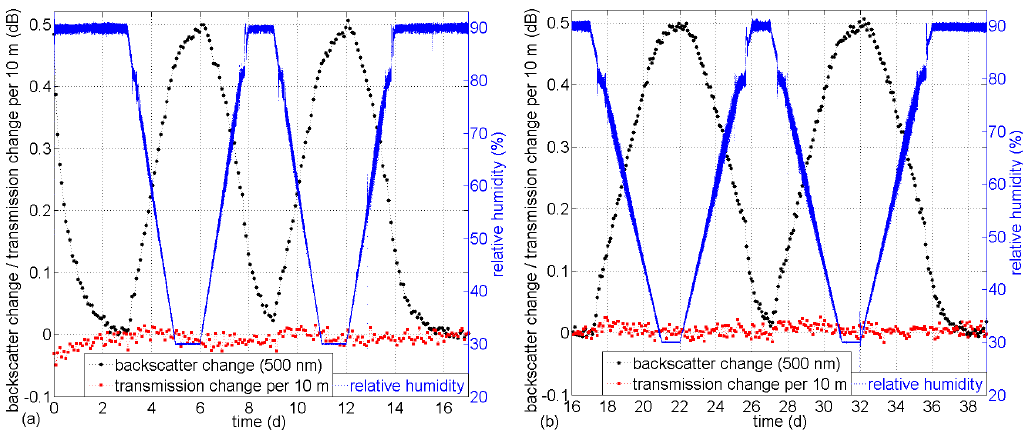
Figure 5. Backscatter change and transmission change during gradual RH changes at 500 nm